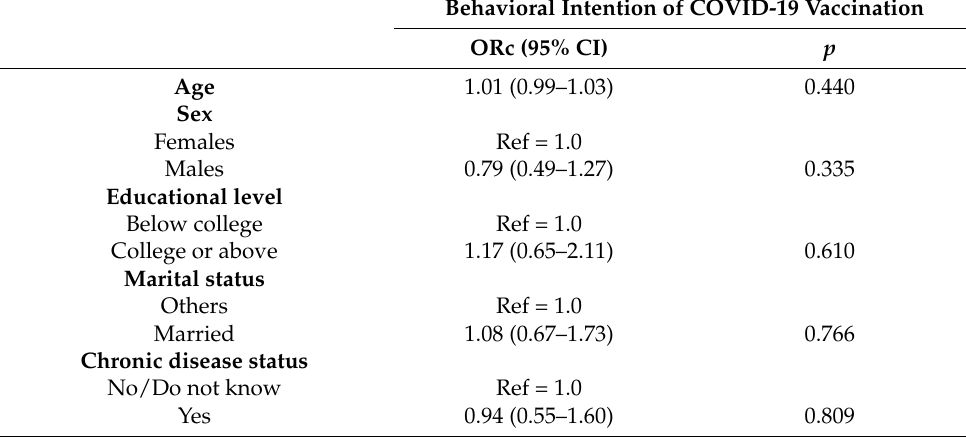
Table 2. Background factors of behavioral intention for COVID-19 vaccination (pooled sample: n = 503).